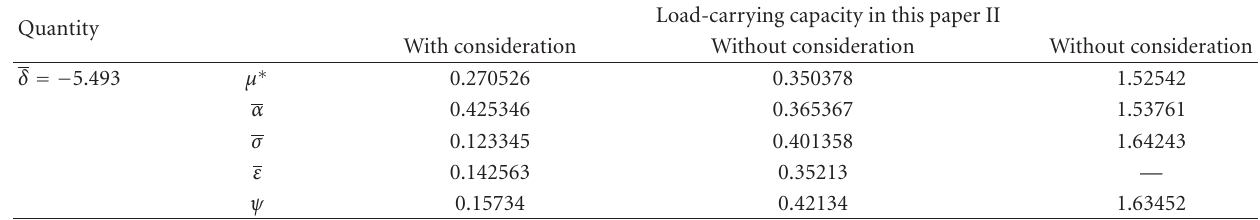
Load-carrying capacity in this paper II Quantity With consideration Without consideration Without